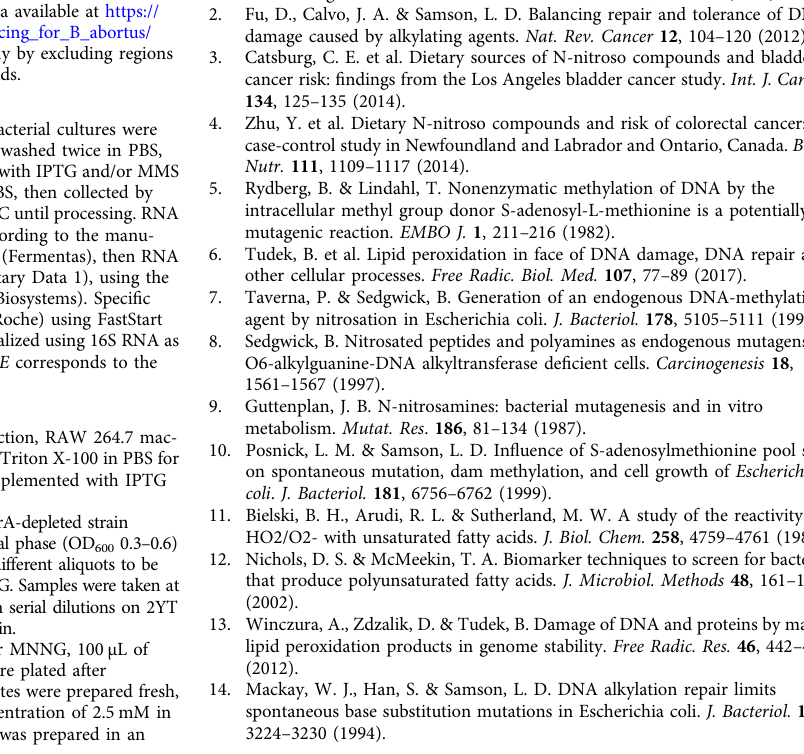
table (performed by Genomics Core Leuven, Belgium; data available at https:// fi gshare.com/articles/Summary_of_whole_genome_sequencing_for_B_abortus/ 9747653). Mutations were counted for each isolated colony by excluding regions corresponding to microsatellites and with less than 10 reads. Reverse transcription followed by quantitative PCR . Bacterial cultures were grown in rich medium to exponential phase (OD 600 0.3), washed twice in PBS, and allowed to grow in rich medium supplemented or not with IPTG and/or MMS 2.5mM (Sigma) for 5h. Bacteria were washed twice in PBS, then collected by centrifugation, and immediately frozen and stored at − 80 °C until processing. RNA was extracted using TriPure isolation reagent (Roche) according to the manu- facturer ’ s instructions. Samples were treated with DNase I (Fermentas), then RNA was reverse transcribed with speci fi c primers (Supplementary Data 1), using the High capacity cDNA Reverse Transcription kit (Applied Biosystems). Speci fi c cDNAs were ampli fi ed on a LightCycler 96 Instrument (Roche) using FastStart Universal SYBR Green Master (Roche). Results were normalized using 16S RNA as a reference with the E − ΔΔ Ct calculation method 81 , where E corresponds to